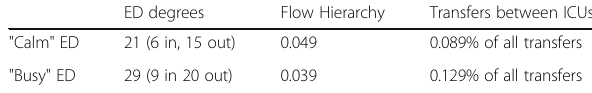
Table 1 (abstract 001637). See text for